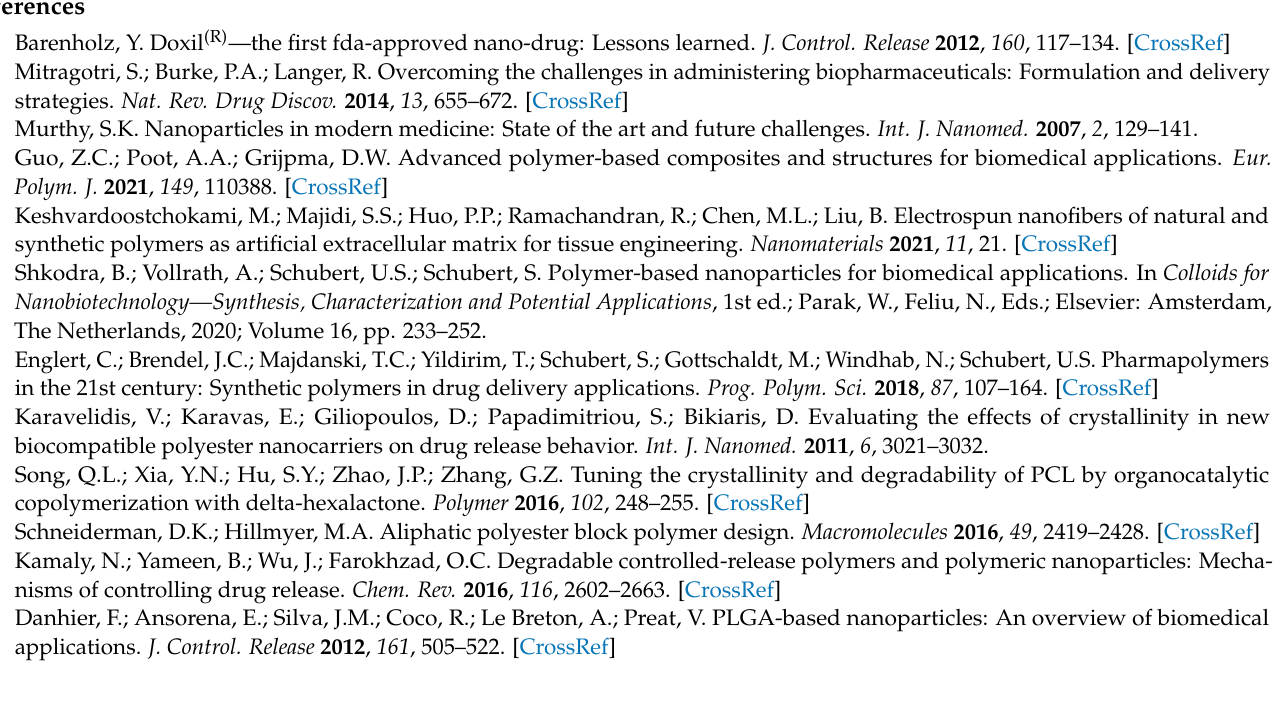
Figure S4: Influence of the residual PVA on the efficiency of drug-loaded PCL NPs on 5-LO inhibition. Black-circled data points represent PCL polymers with bulk degree of crystallinity below 10% and glass transition temperature Tg < 37 ◦ C. Table S1: Molar mass and composition of the (co)polyesters. Details are described in a previous publication, Table S2: Properties of PCL[BRP-187] NPs